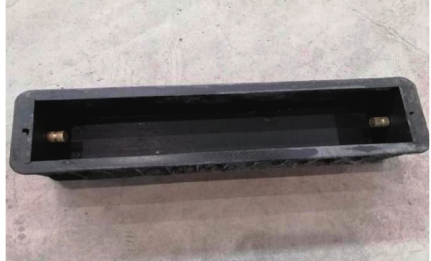
Figure 1: Concrete shrinkage test block